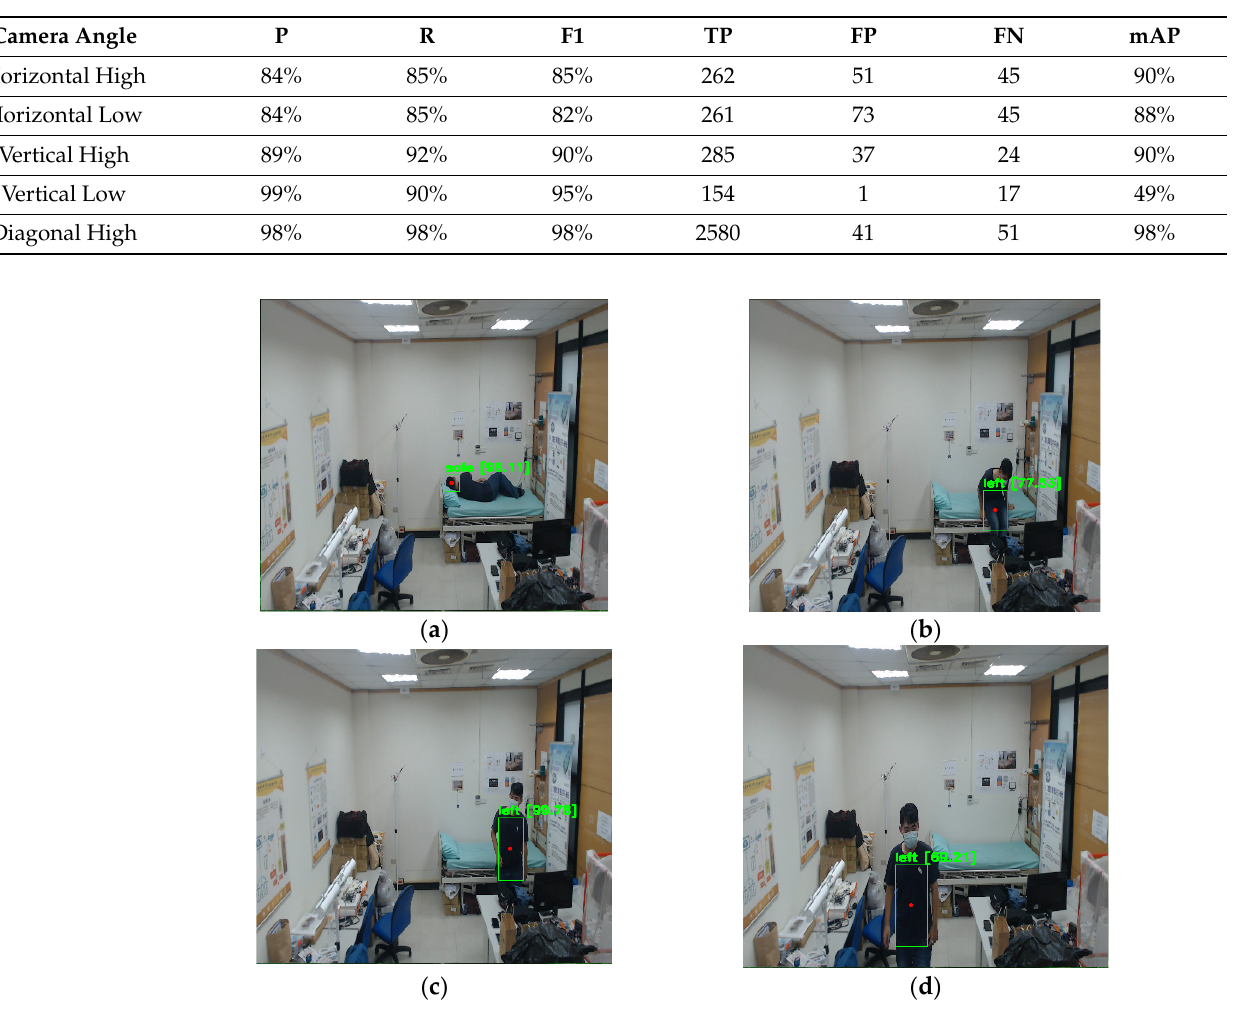
Figure 8. Images from the diagonal high angle: ( a ) lay on the bed; ( b ) get up and turn around; ( c ) sit on the edge of bed; ( d ) exit the bed.